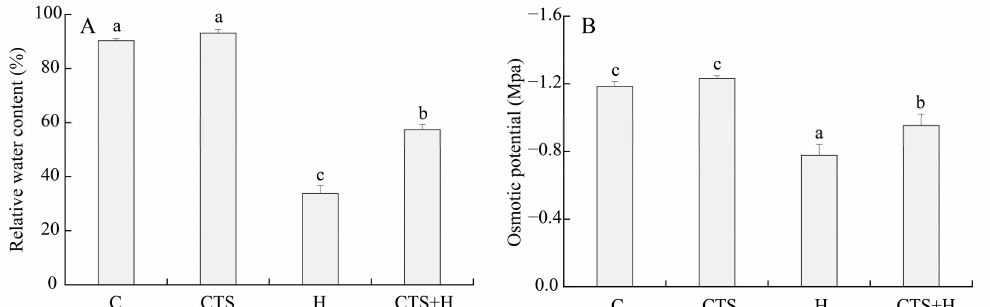
Figure 1. Effect of chitosan on ( A ) relative water content (RWC) and ( B ) osmotic potential (OP) under control and heat stress conditions. Vertical bars above columns indicate ± standard error (SE) of means ( n = 4) and different letters above columns indicate significant differences among treatments ( p ≤ 0.05).